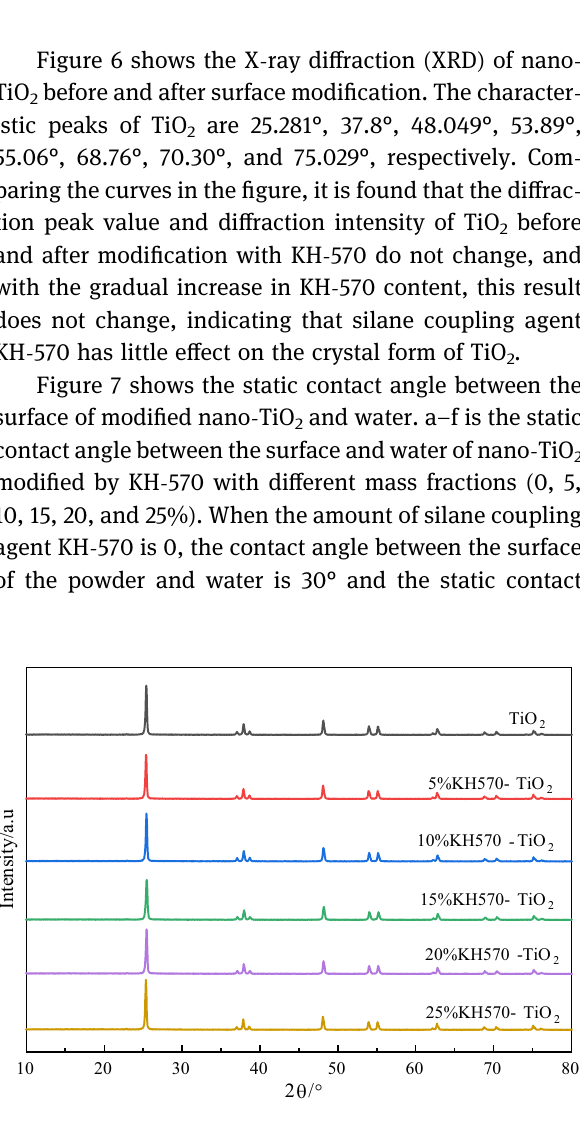
Figure 6: XRD of nano - TiO 2 before and after modi fi cation.